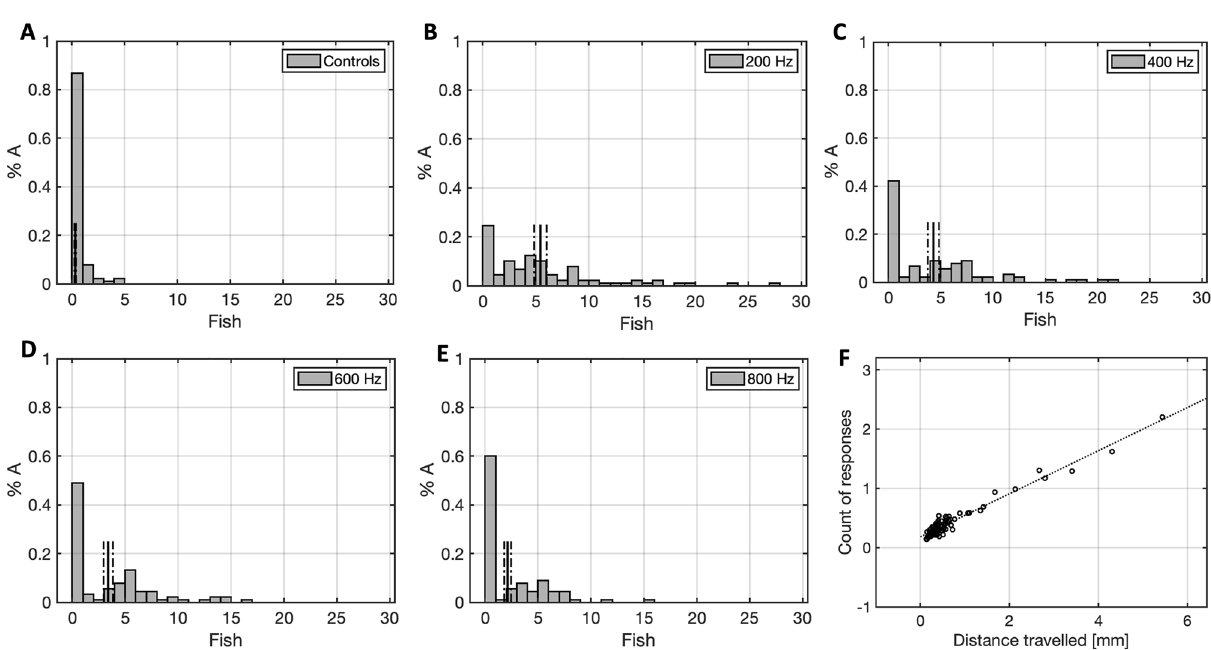
Figure 3. ( A – E ) Histograms of the percentage (%) amplitude (M [black line] ± 1 SE [dotted line]) in each of the experimental conditions. (F) Relationship, with line of best fit, between the fish mean count of responses and mean distance travelled, at each stimulus, for all frequency